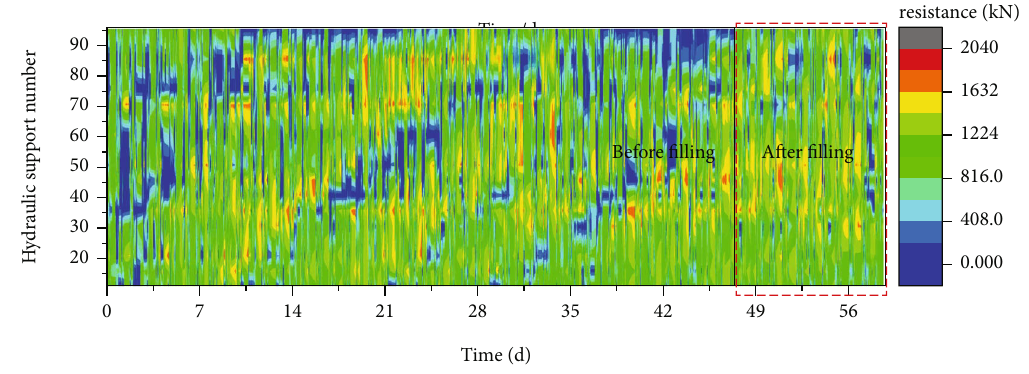
Figure 14: Working resistance distribution of hydraulic